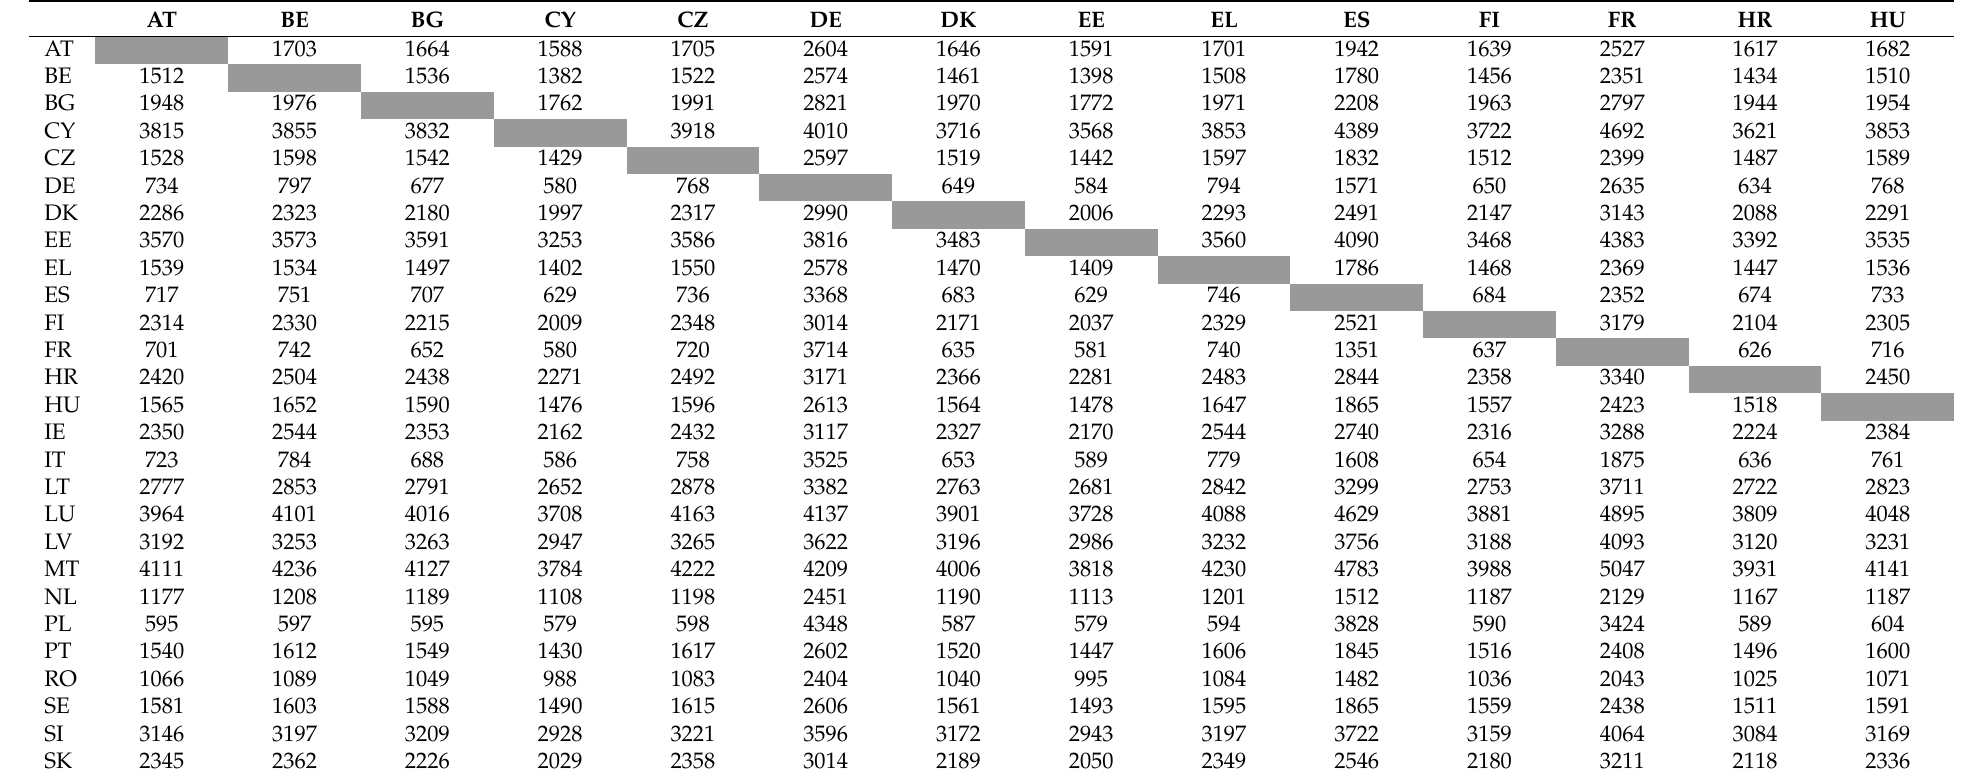
Table A4. The impact of additional departures to Brexit with populations for 2015, unadjusted